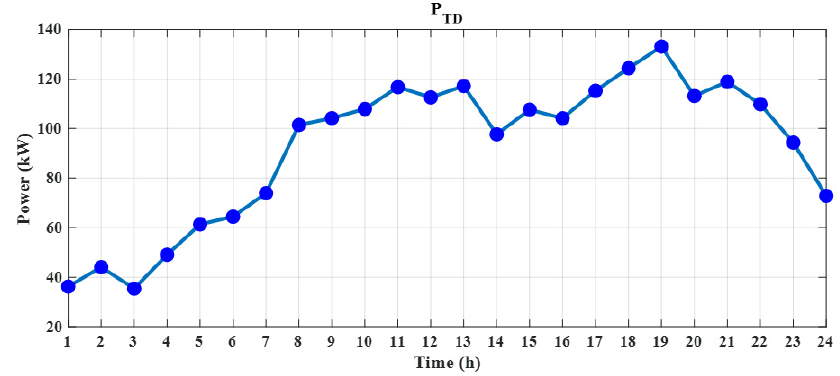
Figure 7. Daily thermal load demand.